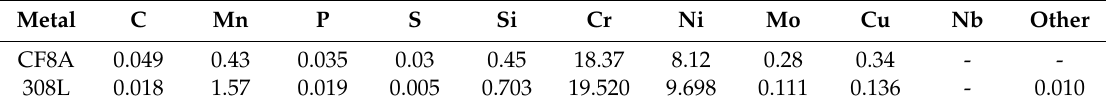
Table 1. Chemical compositions of the base metal and filler metal (mass%).